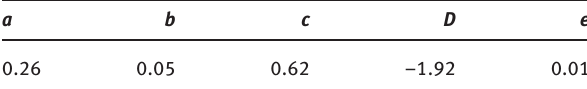
experimental data.